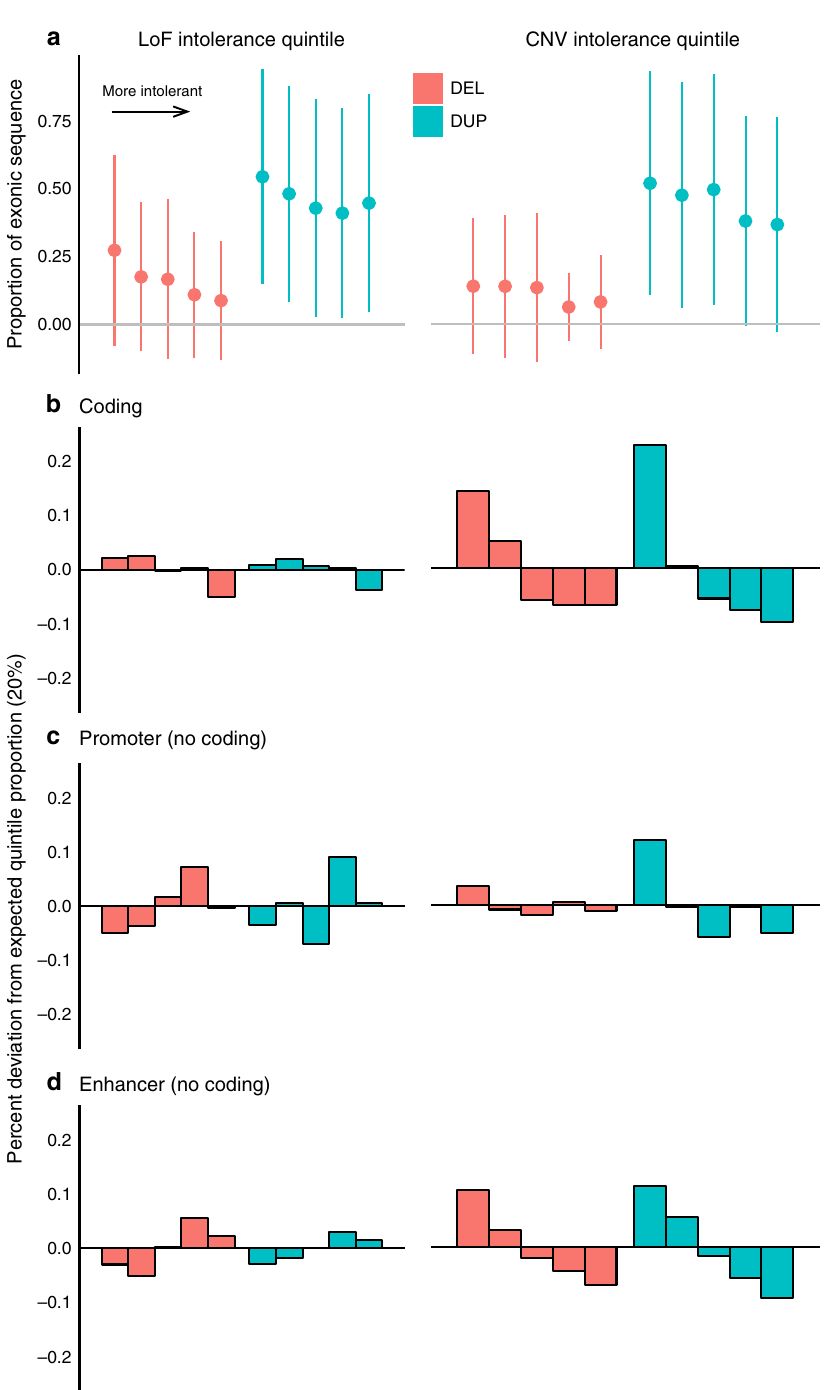
Fig. 4 Genes intolerant to variation are less likely to be affected by genic or regulatory SVs. Each plot strati fi es genes using either the LoF intolerance metric or the CNV intolerance metric that have been split into quintiles (20% bins) ordered left to right from least to most intolerant genes and by deletion (red) and duplication (blue). The plots show the effect of this strati fi cation on a the proportion of the exonic sequence that is affected showing mean and standard deviation, b the deviation from the expected 20% of CNV that alter exonic sequence, c the deviation from expected for noncoding CNV that alter promoters, and d the deviation from expected for noncoding CNV that alter